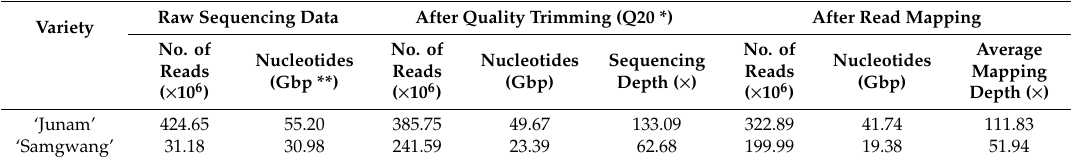
Table 2. Summary of genome sequencing data amount.